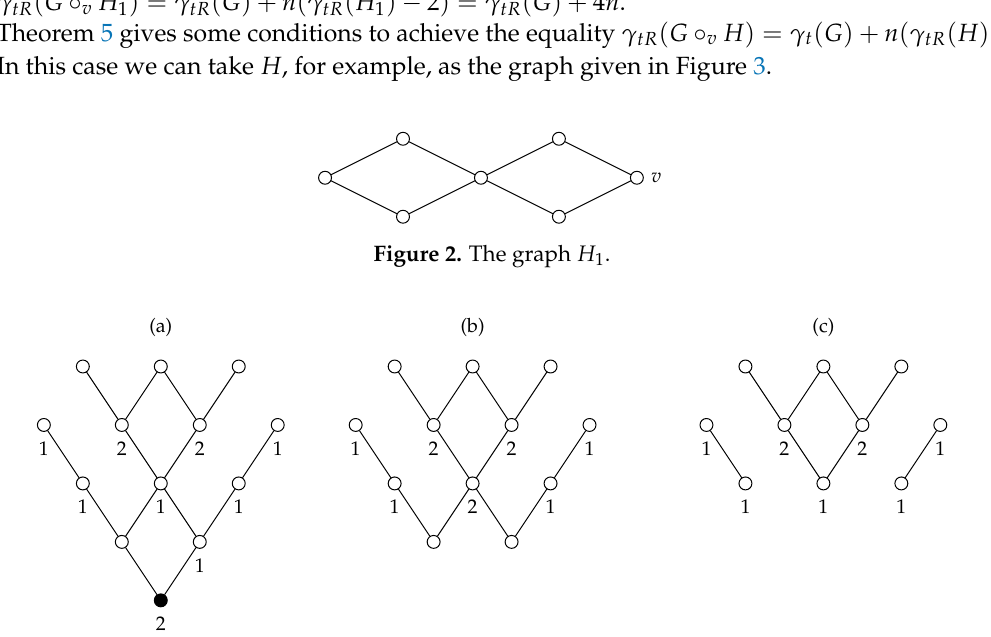
Figure 3. Graphs H , H − v and H − N [ v ] with different labelings (vertices with no drawn label have label zero) to show that γ tR ( H ) = 12 ( a ), γ tR ( H − v ) = 10 ( b ) and γ tR ( H − N [ v ]) = 9 ( c